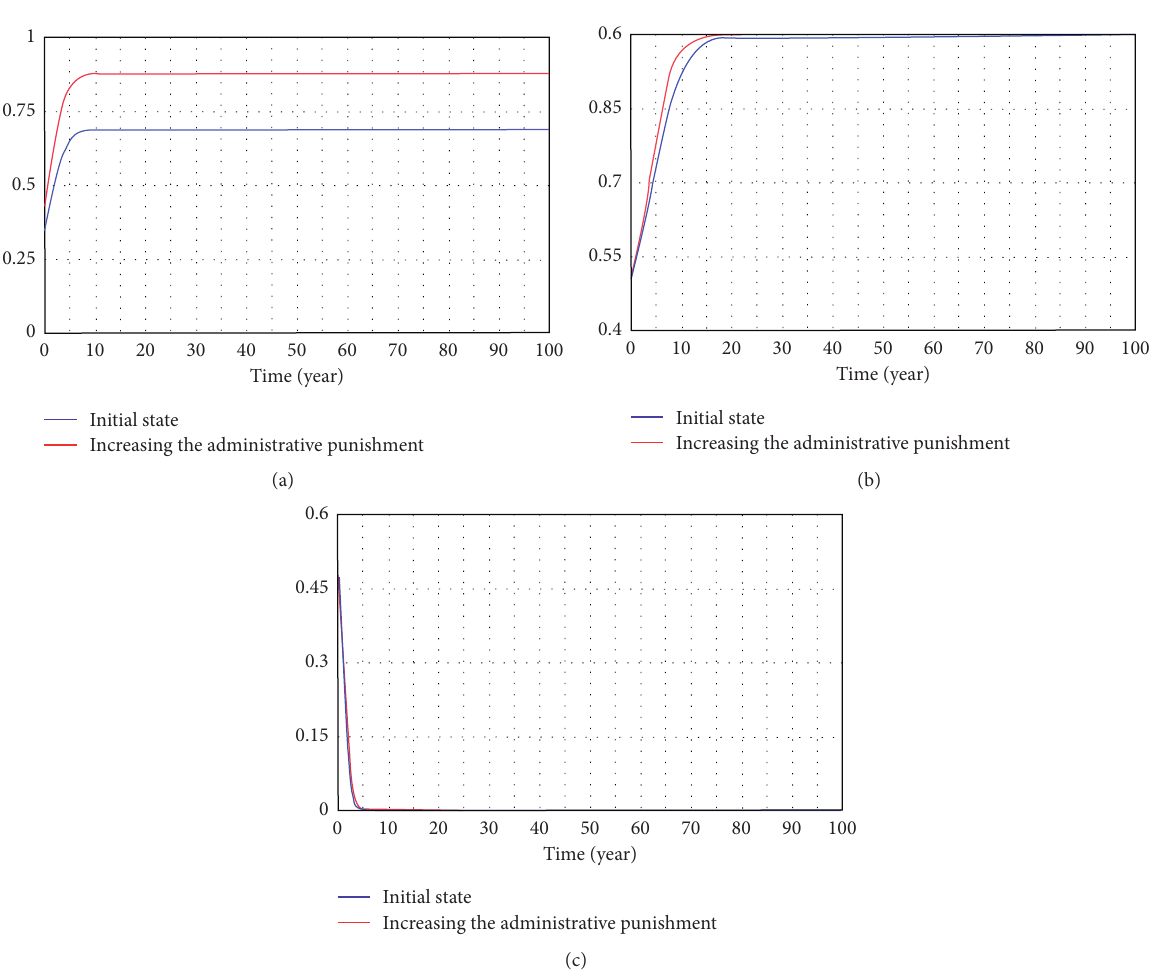
Figure 4: Simulation results under change of administrative sanction. (a) Probability of the enterprise upgrading facilities. (b) Probability of the government’s regular inspection. (c) Probability of the residents appealing to